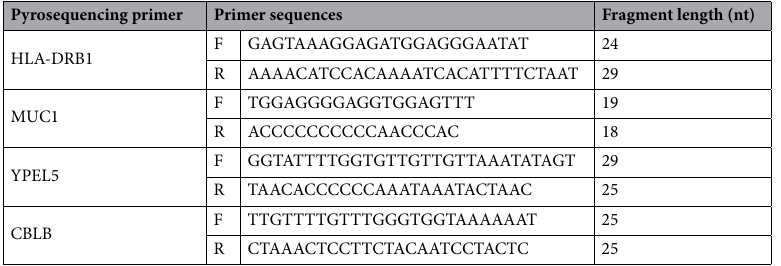
Table 3. Pyrosequencing primer. Note F represented the forward primer of 5 ′ -3 ′ , and R represented the reverse primer of 3 ′ -5’.